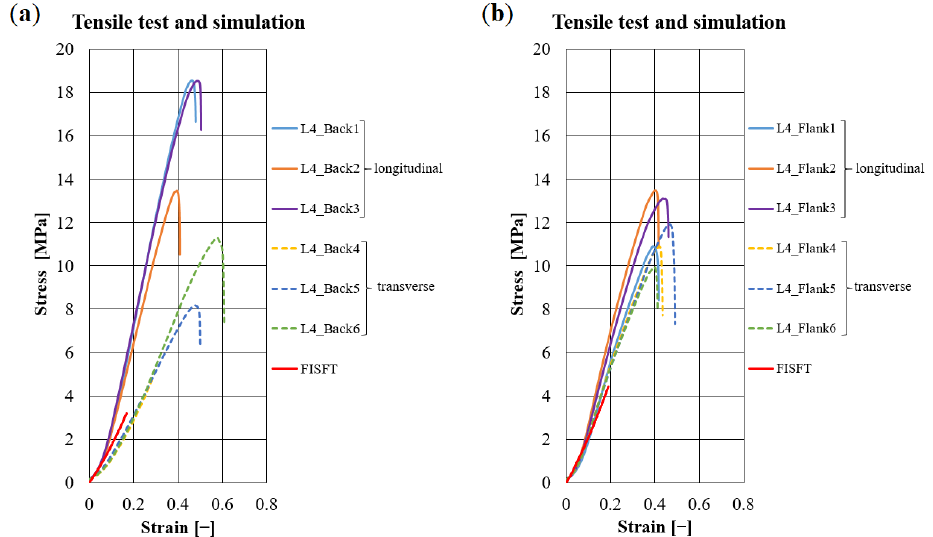
Figure 15. Comparison of tensile test results with the numerical simulations on model meshes fit to the synthetically tanned leather L4: ( a ) back and ( b ) flank.